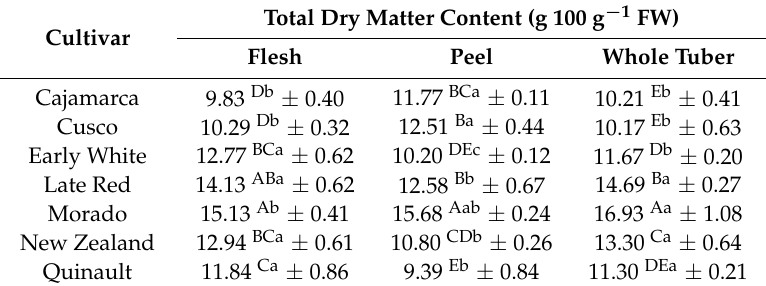
Table 2. Total dry matter content (g 100 g − 1 FW) of the flesh, peel, and whole tuber of different yacon